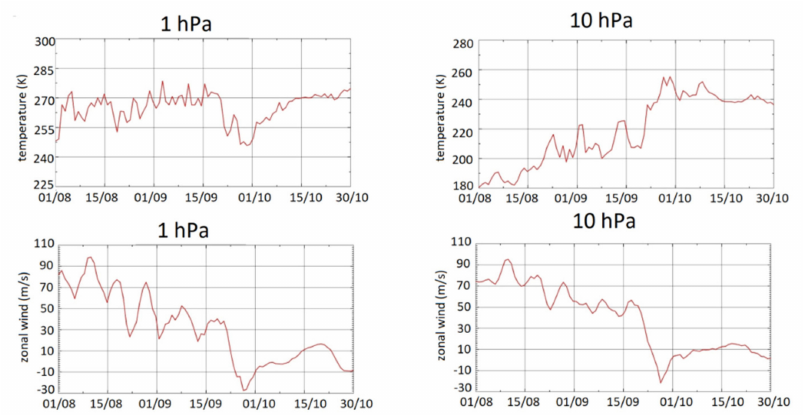
Figure 2. The same as Figure 1 but for the Southern Hemisphere (SH) and period 1 August 2002–30 October